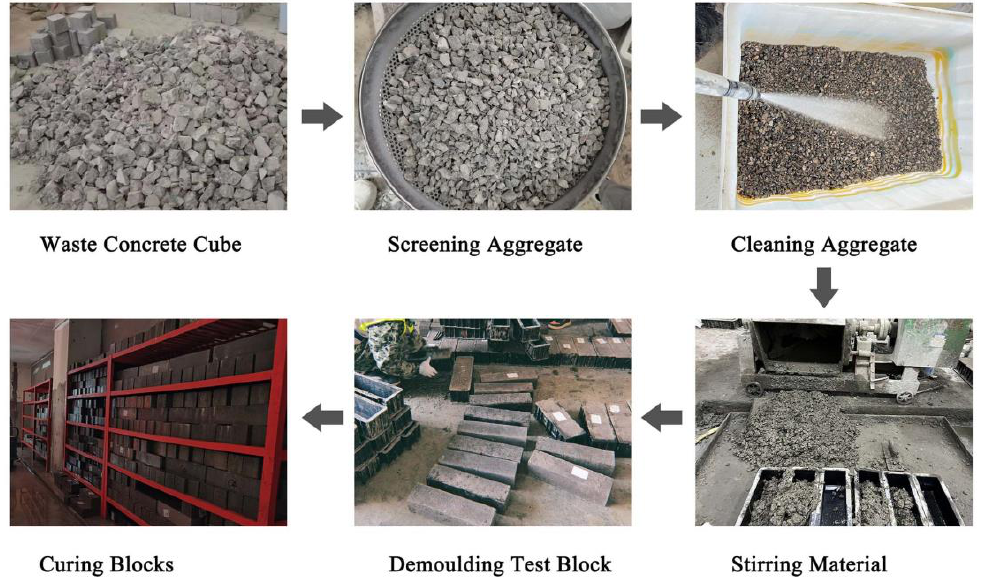
Figure 1. Test-block preparation and maintenance.